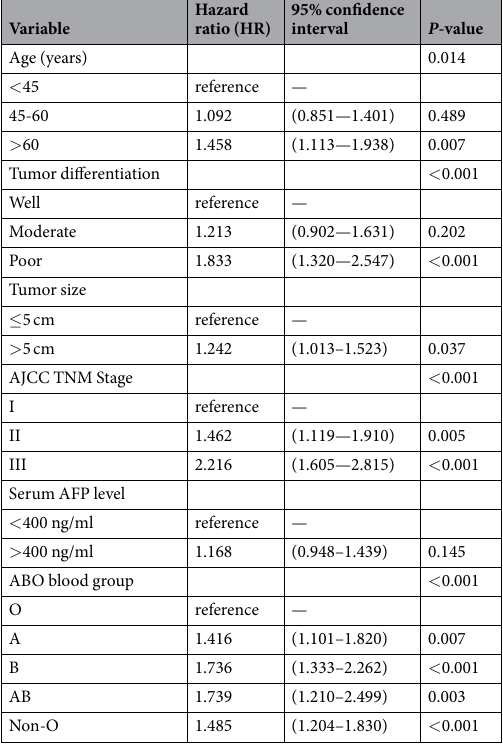
Table 3. Prognostic factors for overall survival by multivariate analysis.